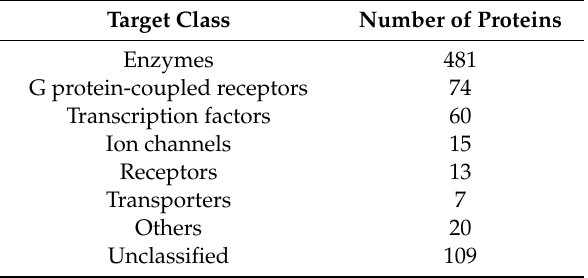
Table 2. Reported are di ff erent target classes and the number of proteins per